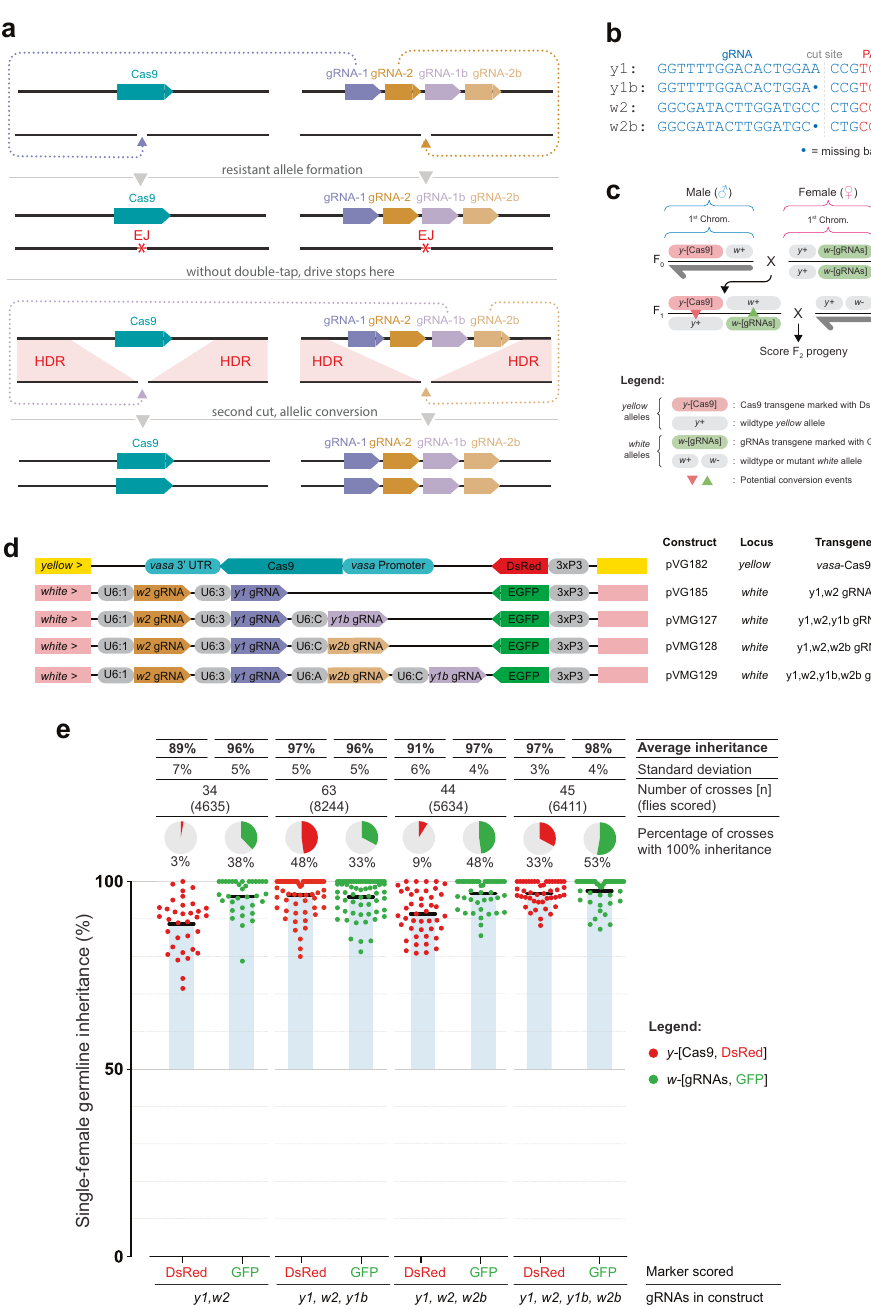
Fig. 1 Double-tap trans-complementing gene-drive (DT-tGD) experimental setup and inheritance analysis. a Schematic of the DT-tGD arrangement in which the Cas9 and gRNA elements are kept as two separate transgenic lines; gRNA-1 and gRNA-2 target the loci at which the Cas9 and gRNA elements are inserted, respectively. When crossed, Cas9 combines with gRNA-1 and gRNA-2 to generate double-strand breaks at each of the wild-type alleles. Repair by end-joining (EJ) pathways rather than homology-directed repair (HDR) would ordinarily halt gene-drive spread. Upon generation of a predicted resistance allele, Cas9 together with double-tap gRNAs gRNA-1b and gRNA-2b can regenerate double-strand breaks at these loci, providing a second chance for the drive elements to be copied by HDR. b gRNAs used in this system. The y1 -gRNA and w2 -gRNA target the wild-type yellow and white loci, respectively. The y1b -gRNA and w2b -gRNA target a single base pair deletion of the most common indel generated at the yellow and white loci, respectively. c Cross scheme used in this experiment. Males carrying the DsRed-marked Cas9 transgene inserted at the yellow locus are crossed to virgin females carrying the GFP-marked gRNA element inserted at the white locus. Trans-heterozygous virgin F 1 females are single-pair crossed to wild-type males, and the resulting progeny are scored for green and red fl uorescence as markers of transgene inheritance. The dark gray half-arrows represent the male Y chromosome. d Transgenic fl y lines used in this experiment. vasa -driven Cas9 is marked with DsRed and inserted in the yellow locus. Various gRNA combinations, in which each gRNA is driven by a U6 promoter, are marked with EGFP and inserted in the white locus. e Single female germline inheritance rates as measured by fl uorescence phenotypes detected in the F 2 progeny. Black bars represent the average inheritance rates, and blue shaded boxes indicate the deviation from the normally expected 50% Mendelian inheritance. Pie charts represent the percentage of crosses that resulted in 100% inheritance of that